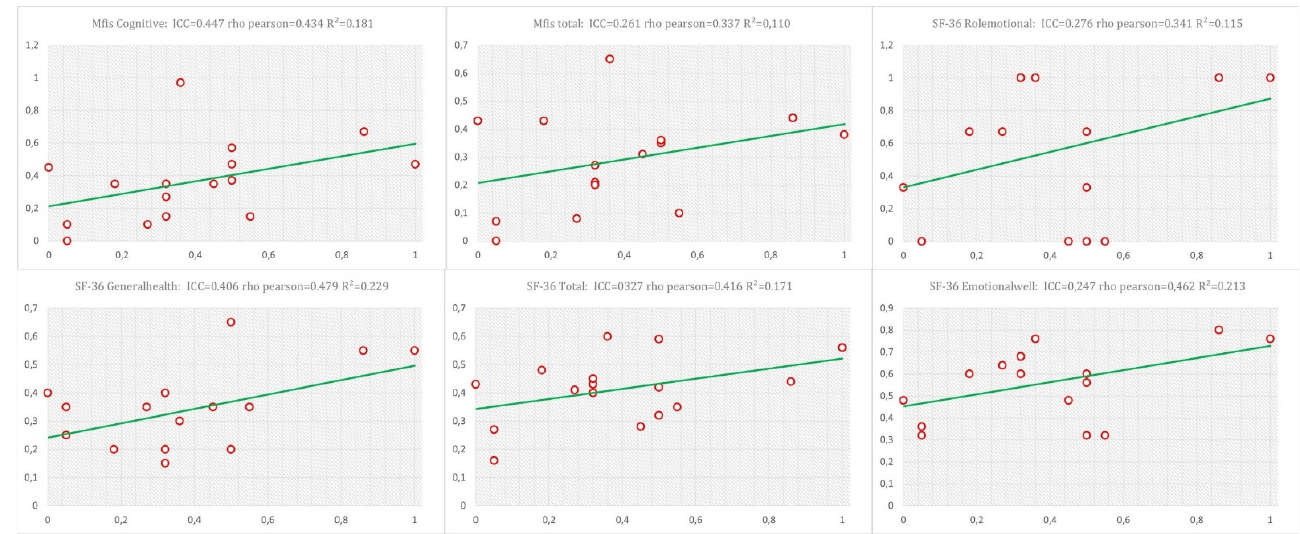
Figure 2. Correlation graphical representation of the higher correlations between the distance assessed by the app with MFIS and SF-36 variables. ICC—intraclass correlation coefficient; MFIS—Modified Fatigue Impact Scale; SF-36—Short Form-36 Health Survey. Table 2. Construct validity of RUNZI ® app with MFIS and the SF-36.